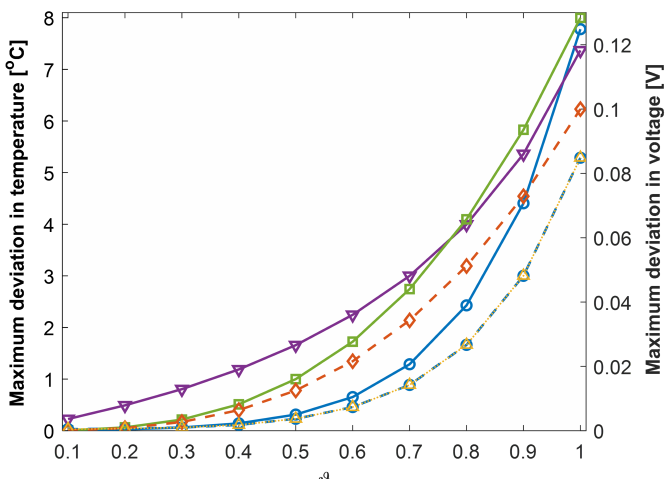
Figure 4. Variation in maximum deviation of temperature and voltage with anomaly magnitude; solid lines represent temperature deviations (left axis) and dashed/dotted lines represent voltage deviations: (cid:13) ISC, (cid:53) air flow, (cid:3) loose temperature sense lead, ♦ loose voltage sense lead, and (cid:52) voltage dropout.